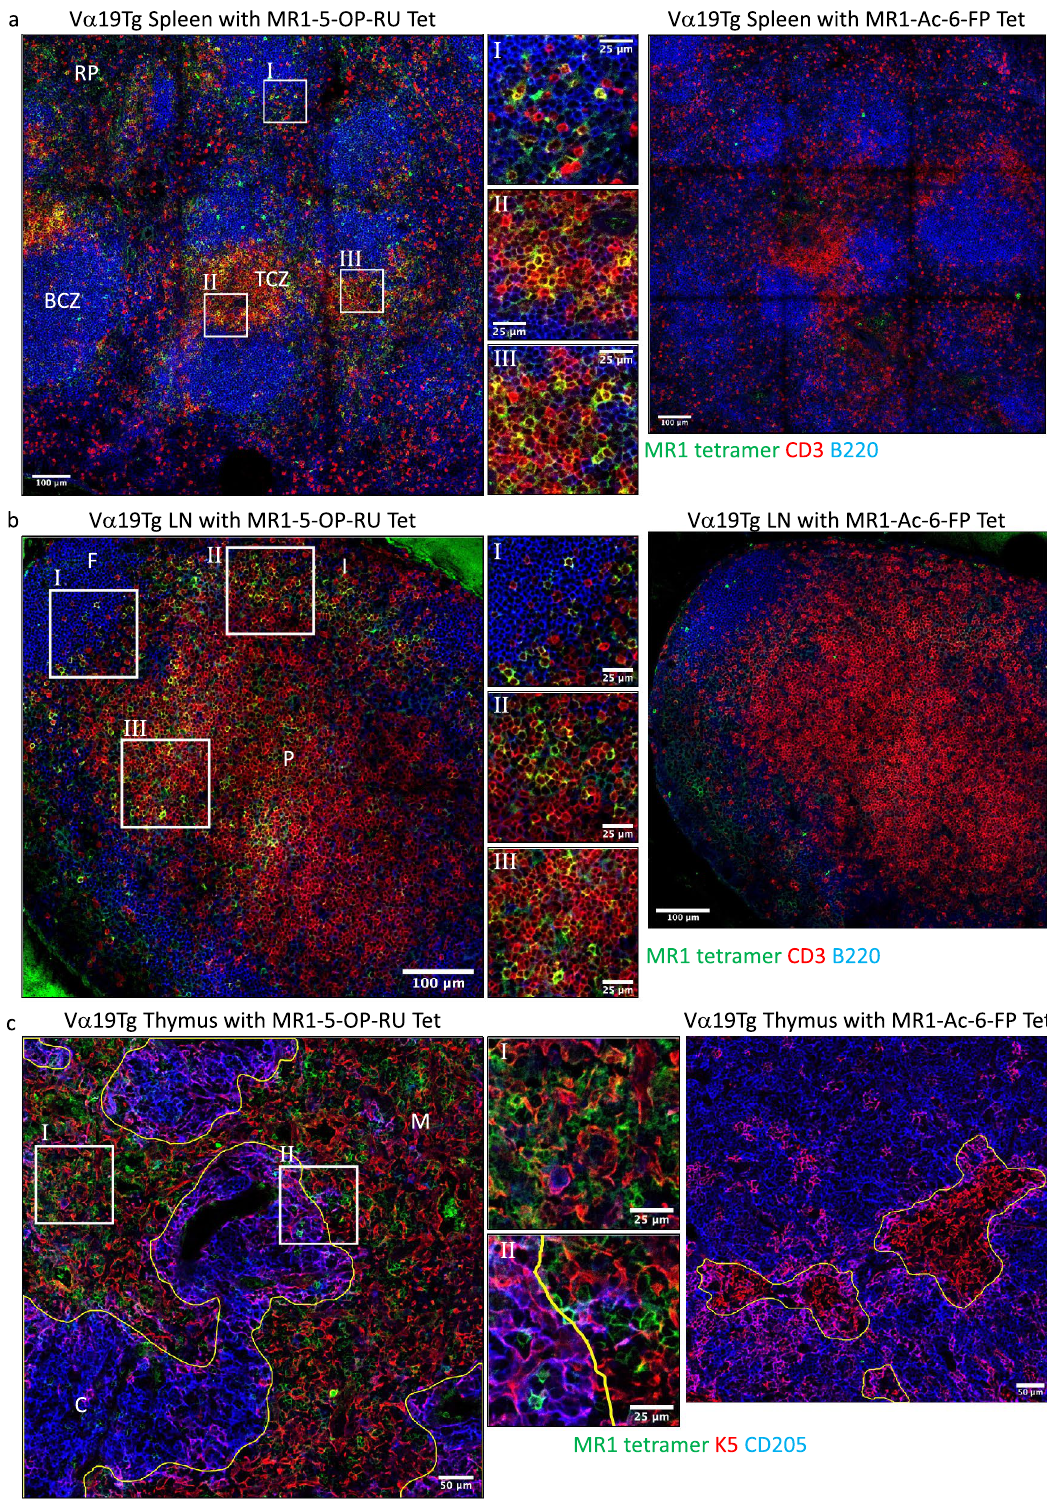
Figure 7. Identification of MAIT cells in Vα19 TCR transgenic mice in situ. Sections from Vα19Tg.Cα −/− mice spleen ( a ), LN ( b ) and thymus ( c ) were stained with MR1 tetramers loaded with 5-OP-RU or Ac-6-FP and anti-CD3 and anti-B220 antibodies or anti-CD205 and cytokeratin-5 (K5). Representative images of spleen and LN showing staining with MR1 tetramer (green), CD3 (red) and B220 (blue), and thymus with cytokeratin-5 (red) and CD205 (blue), scale bar 100 μm. Zoomed regions scale bar 25 μm. Splenic red pulp (RP), B cell zone (BCZ) and T cell zone (TCZ). LN medulla (M), follicle (F) and paracortex (P). Thymic cortex (C) and medulla (M). Microscopy images acquired with Zen 2012 (ZEISS ZEN Microscope Software for Microscope Components) and processed with FIJI/ ImageJ (Fiji (imagej.net)), Imaris 9.3 (Microscopy Image Analysis Software—Imaris—Oxford Instruments (oxinst.com)) and figure compiled with Microsoft PowerPoint (Microsoft PowerPoint Slide Presentation Software|Microsoft 365). Data representative of three independent experiments, Tet =